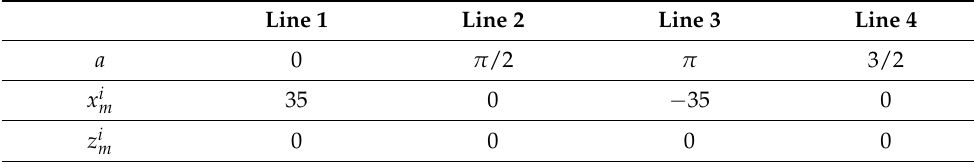
Table 2. Mooring attachment